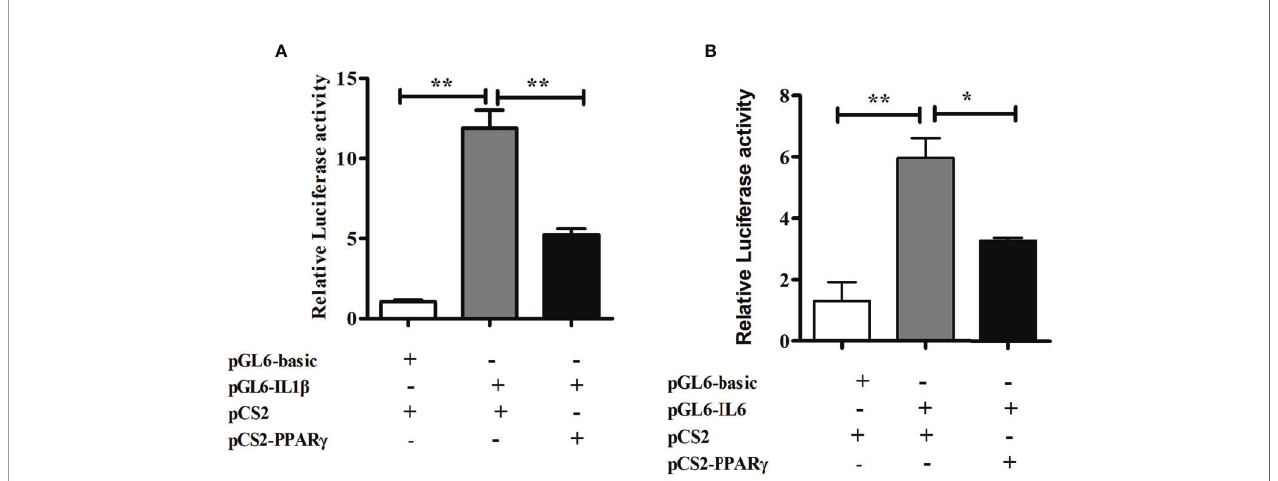
FIGURE 6 | Dual-luciferase analysis of overexpression of PPAR g on large yellow croaker IL1 b (A) and IL6 (B) promoter activity in HEK293T cells. PRL-CMV and pGL6-Basic used as control. Data are presented as means ± S.E.M. (n = 4). * P < 0.05, ** P <